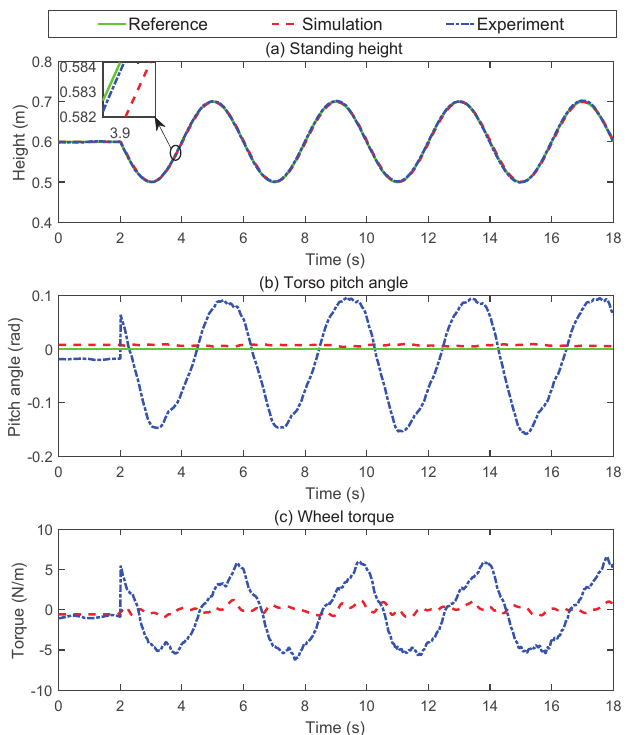
Figure 6. Changing height simulation data curve. ( a ) Stance height tracking trajectory. ( b ) The measurement of the torso pitch angle. ( c ) The actual driving torque of the